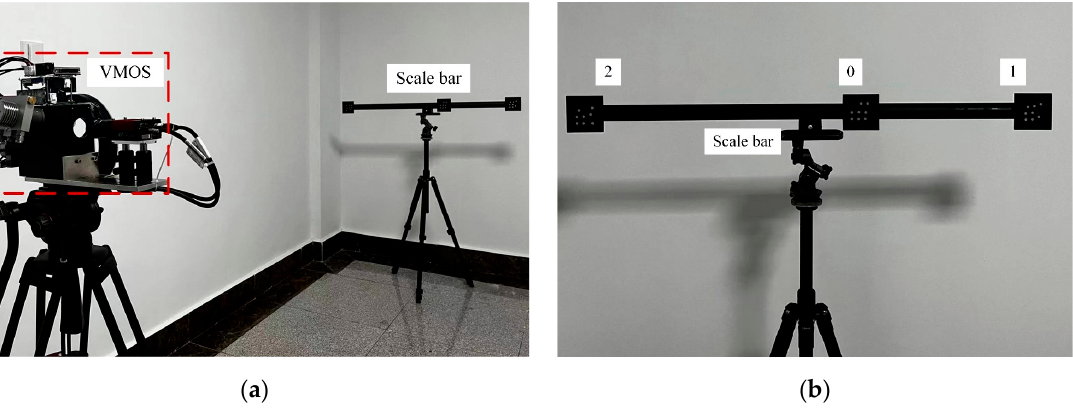
Figure 13. Scene of the scale bar reconstruction experiment. ( a ) The experiment scene. ( b ) Close-up of the scale bar.